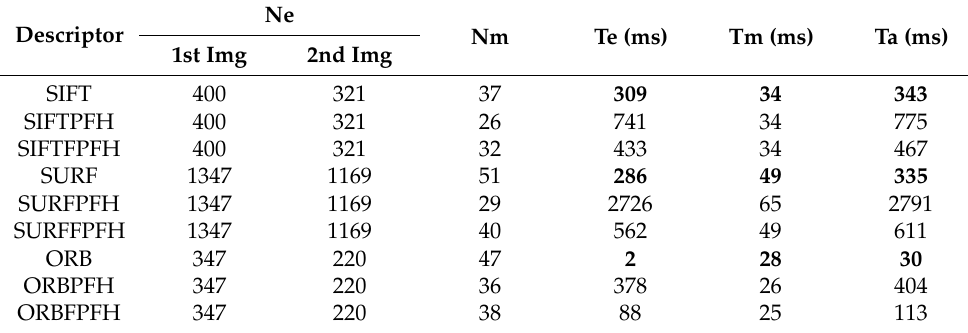
Figure 13. Test images in the KITTI fire dataset. ( a ) frame-000001.color; ( b ) frame-000050.color. Table 2. Test results of the KITTI fire dataset.